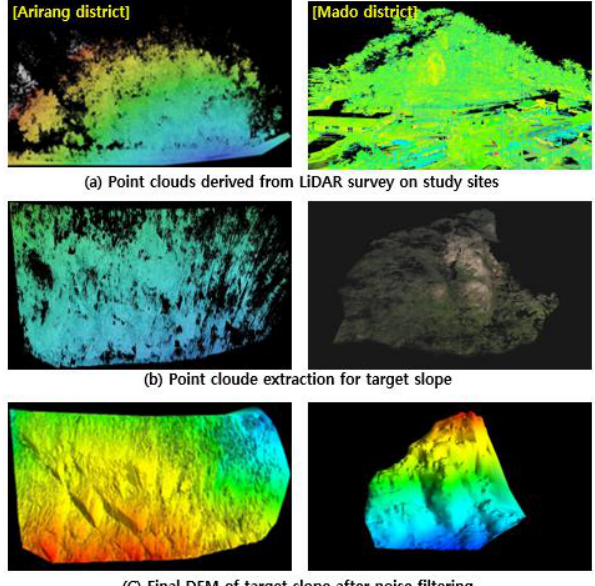
Figure 5. Steep slope outputs through LiDAR data processing